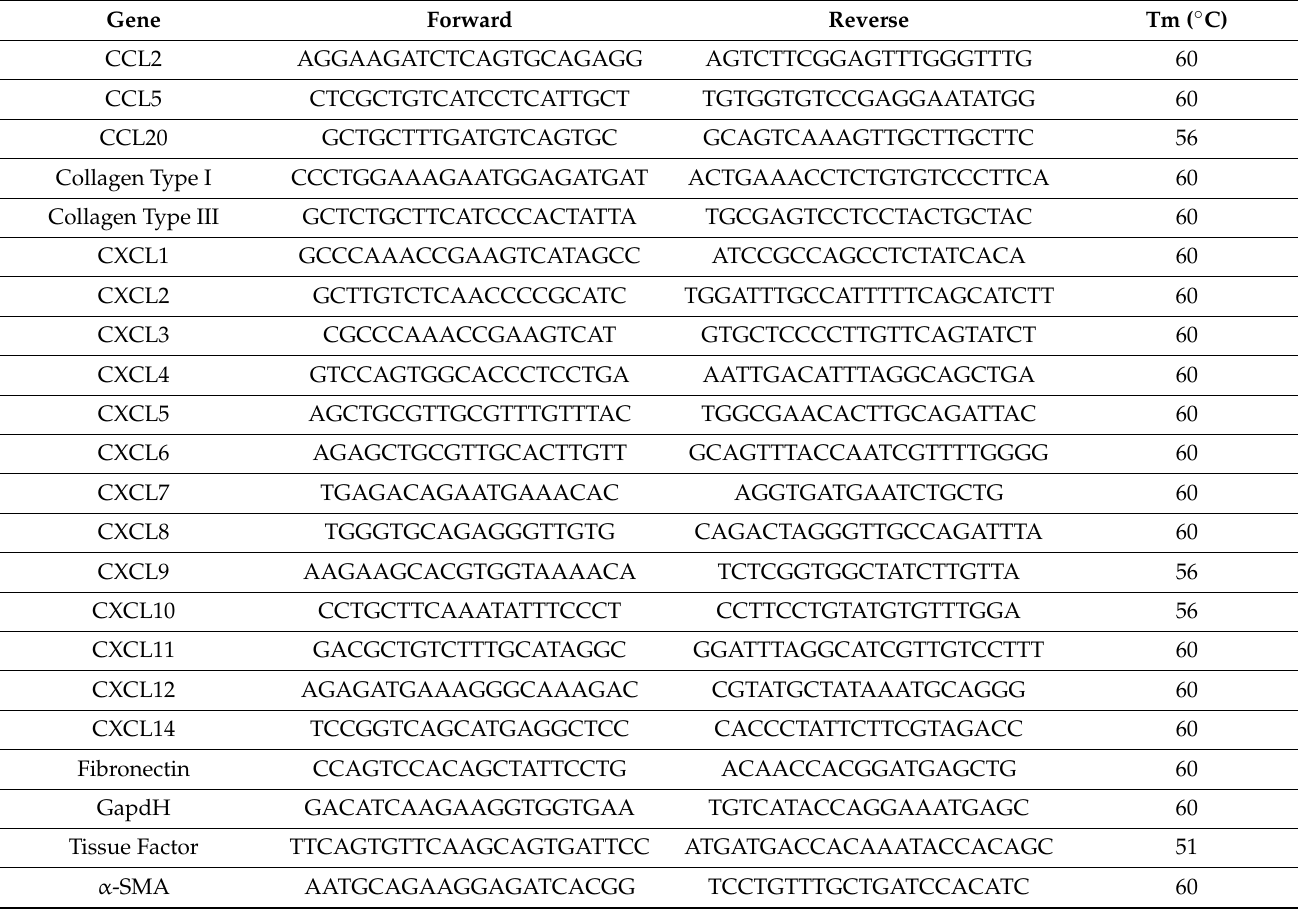
Table 1. Gene specific primer sequences and Tm used in this